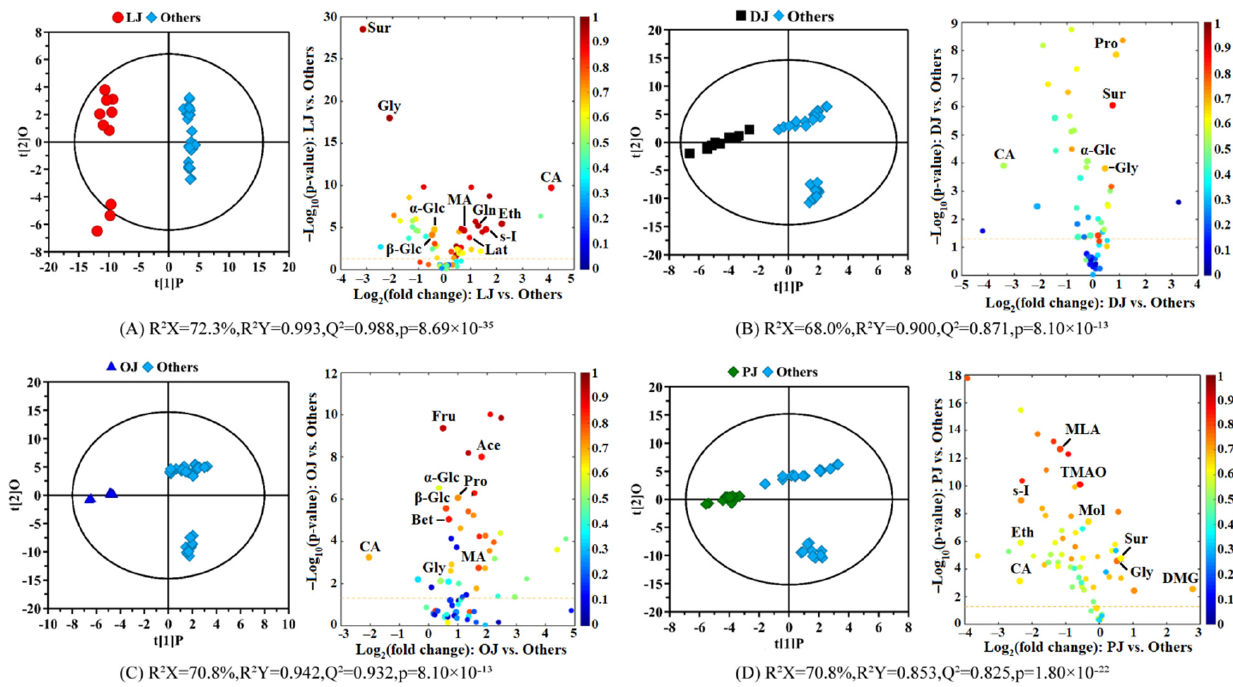
Figure 3. OPLS-DA score plots (left panels) and the corresponding volcano plots (right panels) derived from the NMR data of citrus juices in the different varieties. ( A ) Lemon juice vs. other juices; ( B ) Dekopon juice vs. other juices; ( C ) Sweet orange juice vs. other juices; ( D ) Pomelo juice vs. other juices. LJ: lemon juice; DJ: dekopon juice; OJ: sweet orange juice; PJ: pomelo juice; Others: other three varieties of citrus juices. The marked dots in the volcano plots represent the components with statistically significant differences between the pair-wise groups. The keys of the components were shown in Table 1.